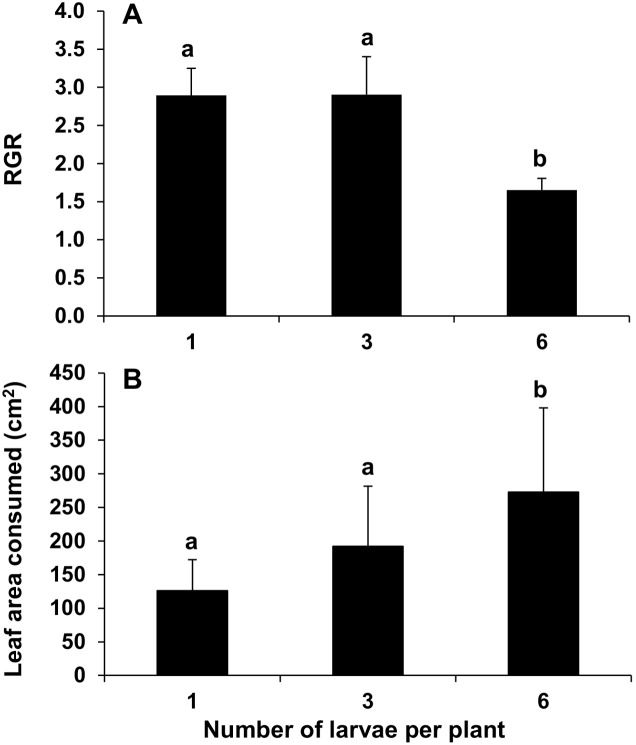
Larval growth and consumption.(A) The relative growth rate (RGR) of fourth-instar Helicoverpa armigera larvae feeding on flowering Nicotiana africana plants for four days and (B) the leaf area consumed per larva (mean ± SE). One (n = 5), three (n = 15) or six larvae (n = 30) were exposed to single leaves per plant. Same letters above bars indicate no significant differences at P>0.05.